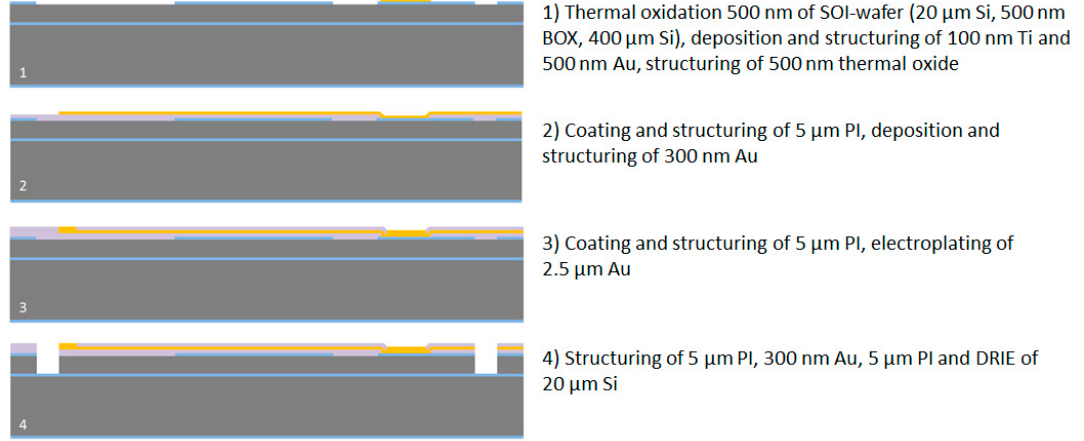
Figure 3. Cross section view of the microfabrication process flow for the wafer device layer.